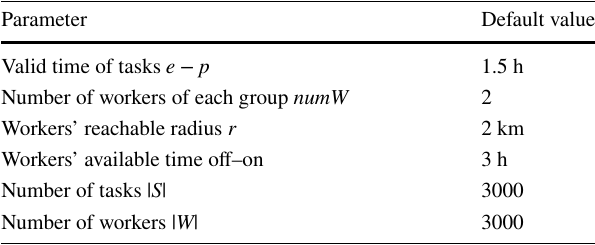
Table 2 Experiment